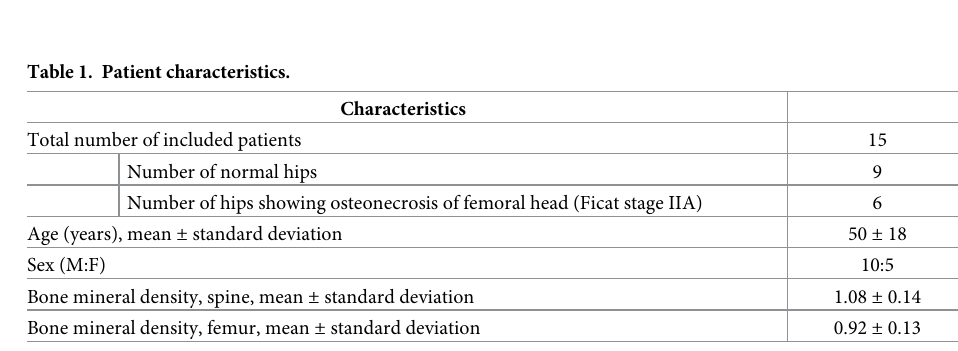
Table 1. Patient